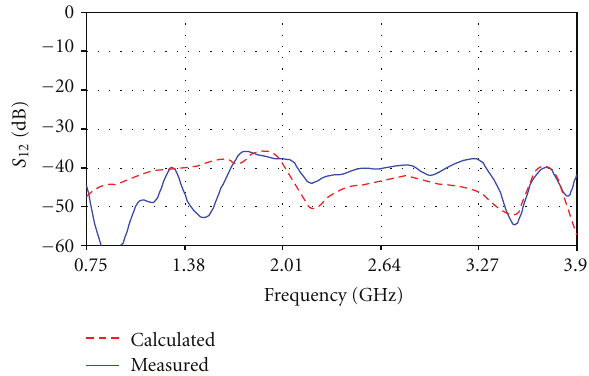
Figure 11: Mutual coupling ( S 12 ) between the antennas of the third configuration while the antennas are perpendicular to each other.